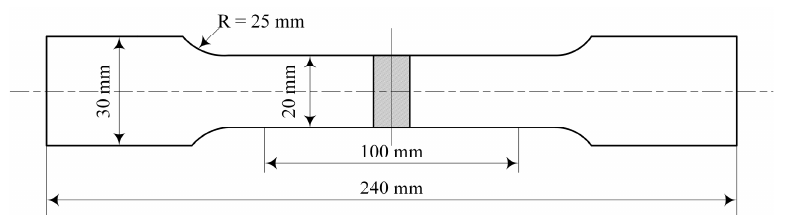
Figure 3. The geometric dimensions of the tensile specimen.